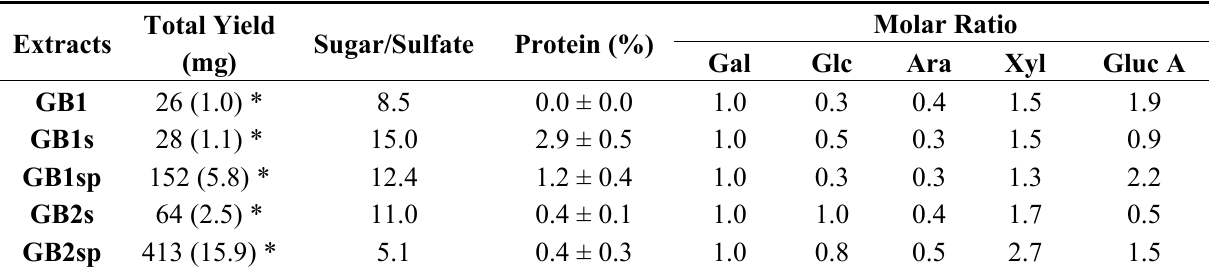
Table 1. Chemical composition of extracts from Gracilaria birdiae . Gal, galactose; Glc, glucose; Ara, arabinose; Xy, xylose; Gluc A, glucuronic acid. * The value in parentheses refers to the ratio of the yield of each condition to the basic condition GB1